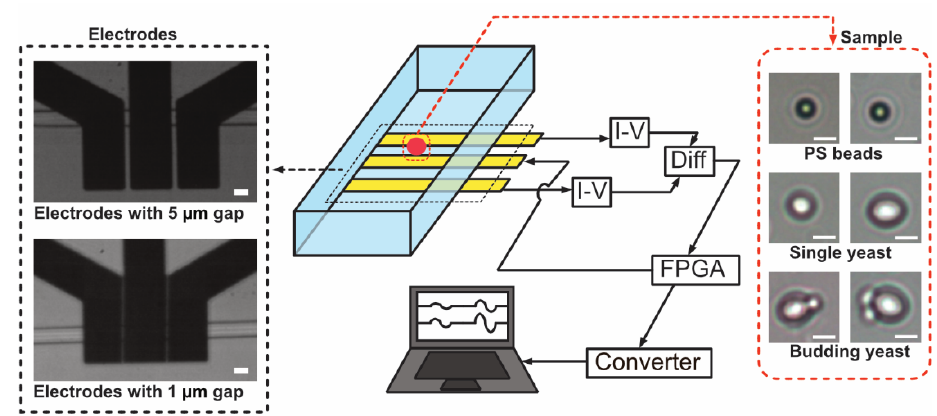
Figure 1. Demonstration of cell impedance detection in this research, sample conclude PS particles and yeast cells (scale bar: 5 µm); two kinds of electrodes have the gap of 5 µm and 1 µm (scale bar: 10 µm).